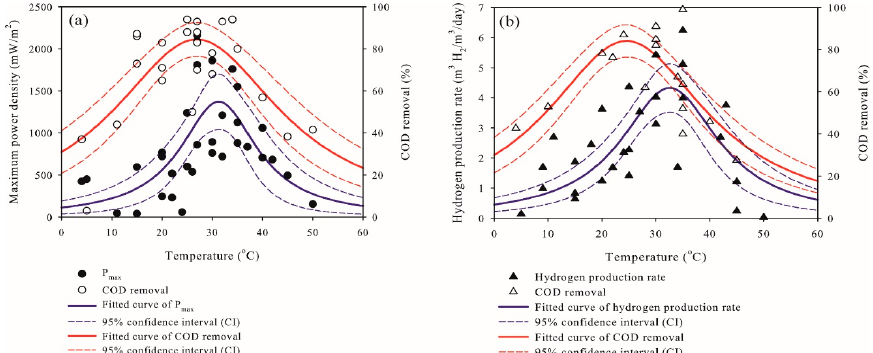
Figure 2. Influences of temperature on ( a ) MFCs’ power generation and chemical oxygen demand (COD) removal and ( b ) MECs’ hydrogen production and COD removal.